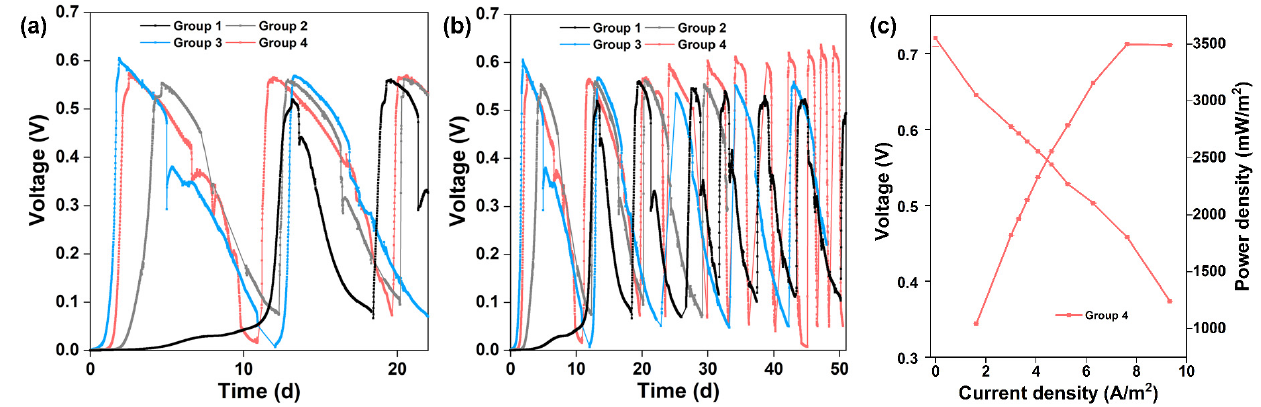
Figure 6. ( a ) Start-up voltages of different groups. ( b ) Long-term MFC stability of different groups. ( c ) Polarization and power density curves of Group 4. ( c ) Polarization and power density curves of Group